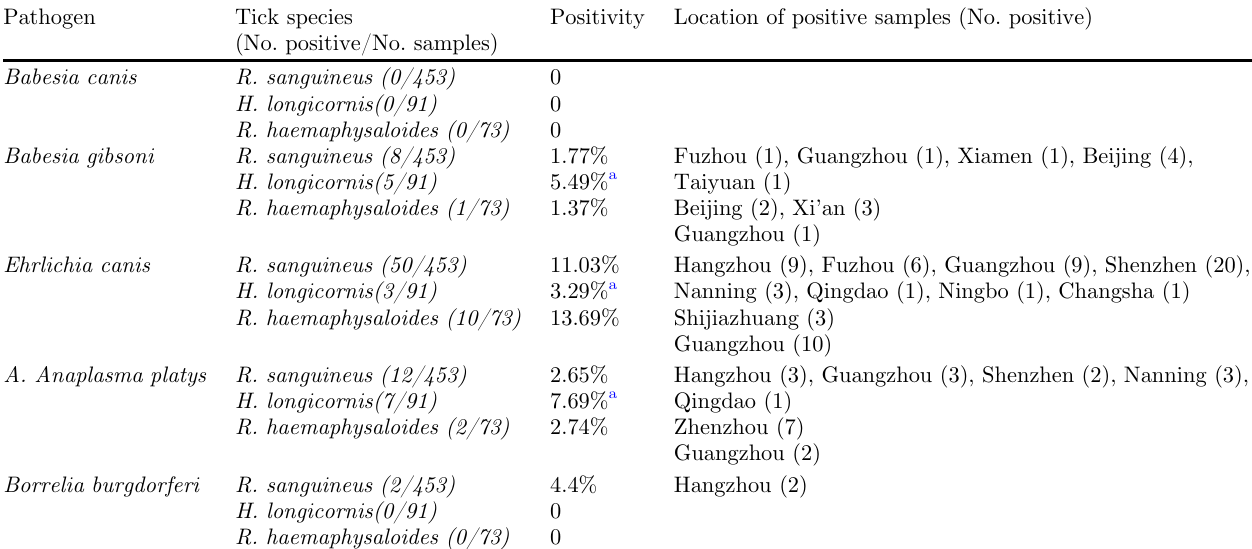
Table 4. Pathogen detection in different ticks collected from different locations. Pathogen Tick species Positivity Location of positive samples (No. (No. positive/No. samples)